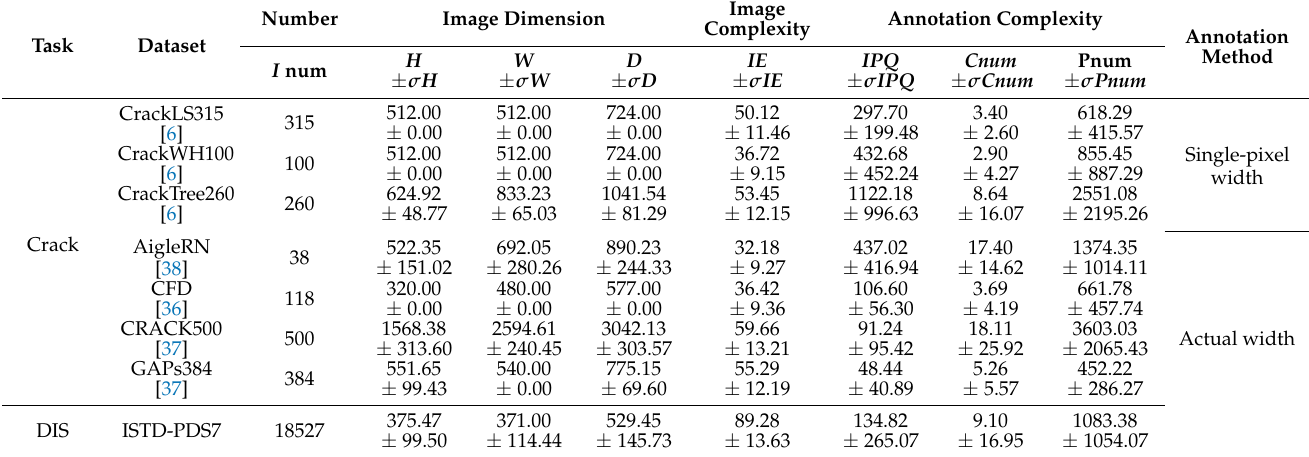
Table 2. Data analysis of the existing